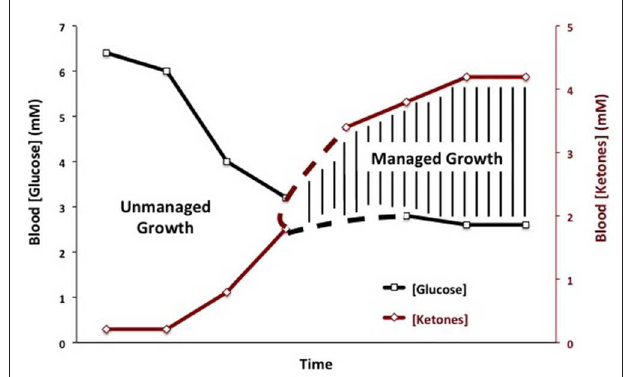
FIGURE 4 | Tracking an individual’s GKI using the Glucose Ketone Index Calculator. Index values of 1.0 or below are considered best for managing cancer growth. Individual glucose and ketone values are shown, along with the corresponding GKI values. The GKI values are plotted over the course of a month, whereas the target GKI value (1.0) is plotted as a single line. Tumor management is predicted to be better (slower growth) within the metabolic target zone than outside of the zone. [Reprinted from Meidenbauer et al. (197), and distributed under a Creative Commons